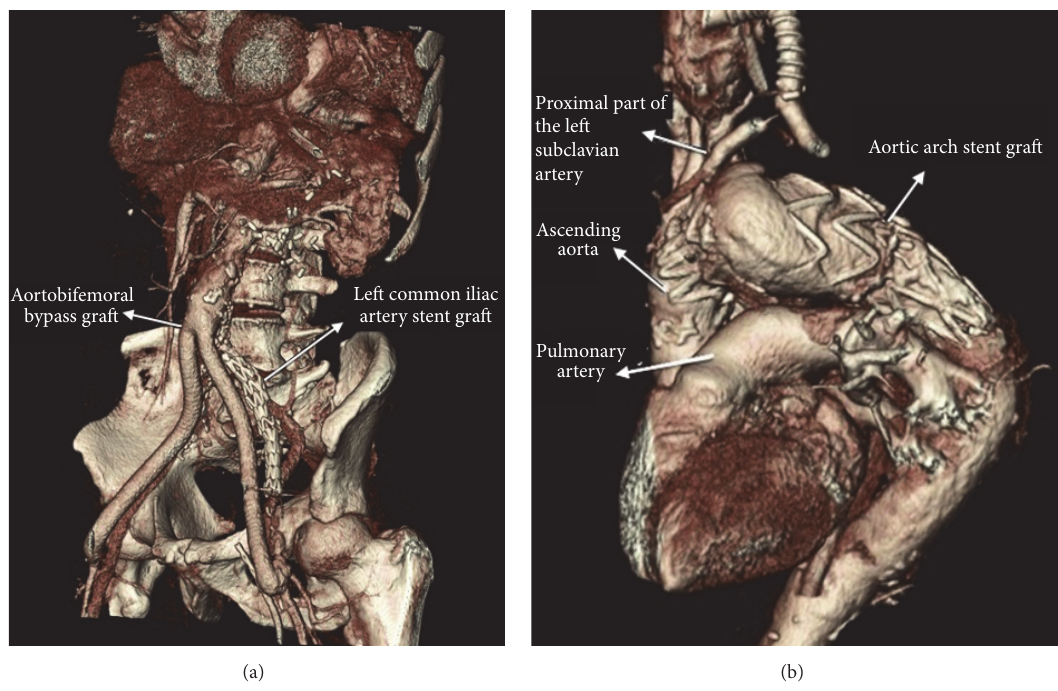
Figure 4: (a) Postoperative control CT angiography image of the stent graft which was applied to the left common iliac artery and the ABF. (b) Postoperative CT angiography view of the stent graft which was used in TEVAR